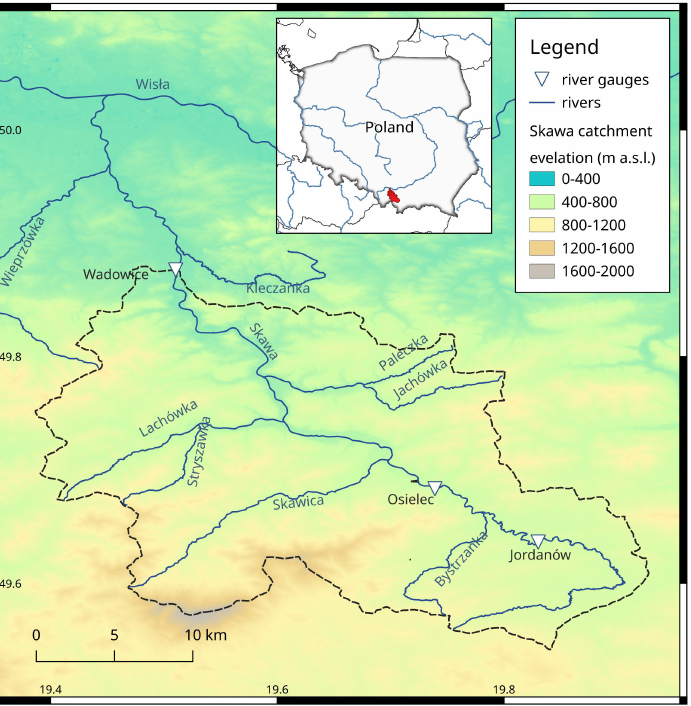
Figure 1. Skawa River catchment (red area) with gauge stations used in presented research—Osielec and